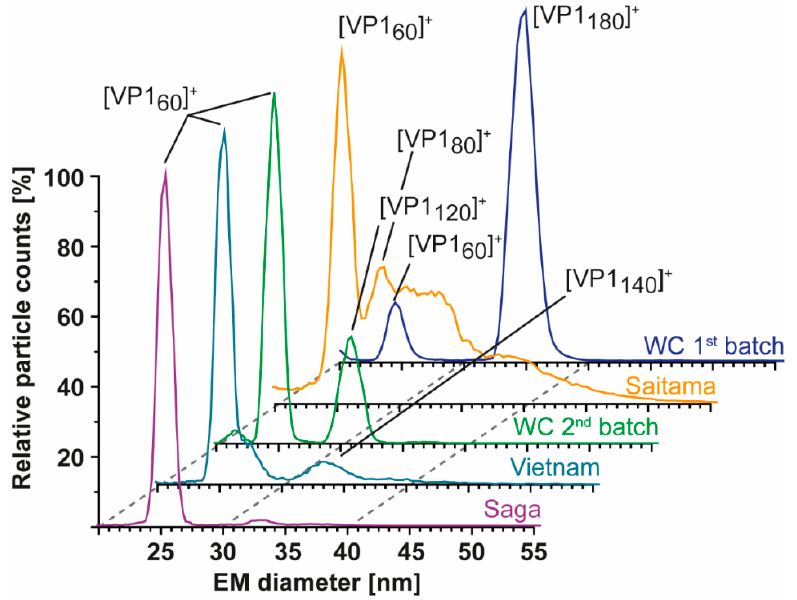
Figure 4. Size-distribution overview of different hNoVLPs with nES GEMMA. All variants are measured at 40 mM ammonium acetate pH 7 and approximately 2–10 µM VP1. From bottom to top GII.4 Saga (purple), GII.10 Vietnam (light blue), GI.1 West Chester batch 2 (WC, green), GII.17 Saitama (orange), and GI.1 West Chester batch 1 (WC, dark blue). West Chester batch 1 is shown as an indication of the expected EMD range for T = 3 particles. Assigned species are annotated. VP1 60-mers were detected in all variants, with less counts in WC batch 1. Next to 60-mers, GII.4 Saga and GII.10 Vietnam show distributions at approx. 33 nm assigned to VP1 140-mer, and WC second batch shows a distinct peak at 30 nm assigned to VP1-120mer. In GII.17 Saitama, at least two peaks can be fitted in the particle distribution accompanying VP1 60-mer annotated as VP1 80-mer and putatively VP1 180-mer.